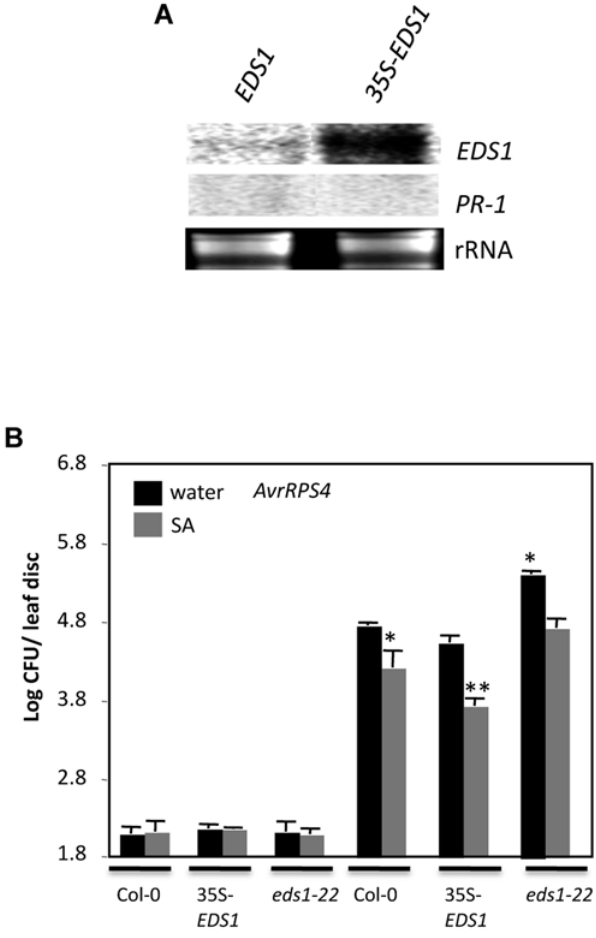
Figure 6. Effect of SA pretreatment and EDS1 overexpression on pathogen resistance. (A) Expression of EDS1 and PR-1 in EDS1 (Col-0) and 35S- EDS1 (Col-0) plants. Total RNA was extracted from 4- week-old plants and ethidium bromide staining of rRNA was used as the loading control. (B) Growth of P. syrinage AvrRPS4 on indicated genotypes (all in Col-0 background). Single asterisks indicate data statistically significant from results for water-treated wt (Col-0) (P , 0.05, n=4). Two asterisks indicate data statistically significant from results for SA–treated wt (Col-0) (P , 0.05, n=4). The error bars indicate SD.